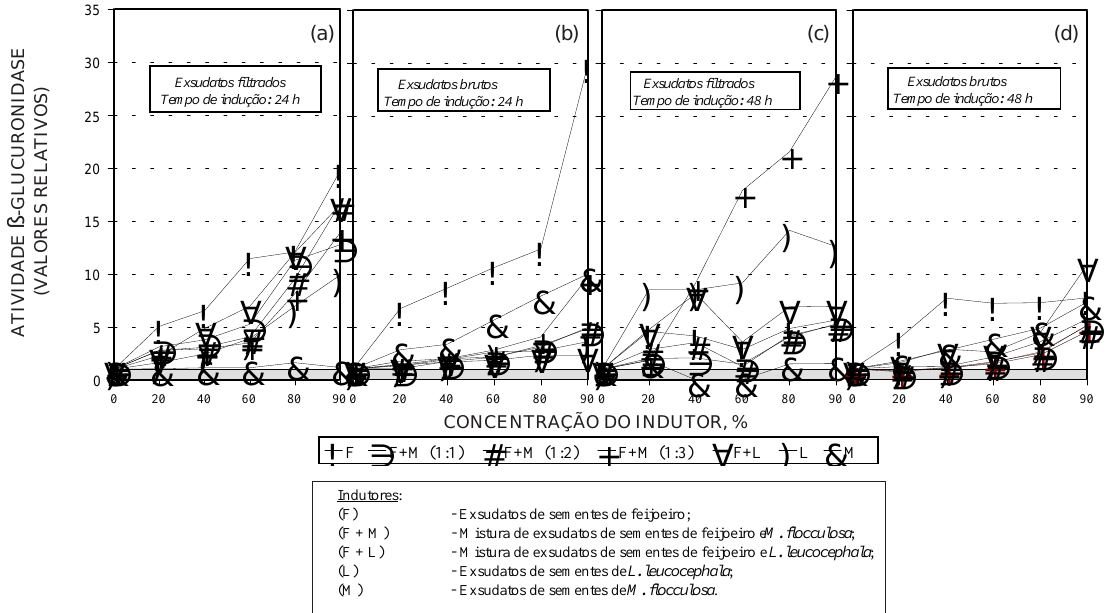
Figura 1. Atividade da enzima ß-glucuronidase, resultante da indução dos genes nod da estirpe CIAT 899 (pGUS 32) pela presença de exsudatos de sementes filtrados (a, c) e brutos (b, d), em dois tempos de indução distintos (24 e 48 h). Valores relativos aos controles (culturas de bactérias na ausência de indutores - exsudatos de sementes). Os valores referentes aos controles são iguais a 1,0.